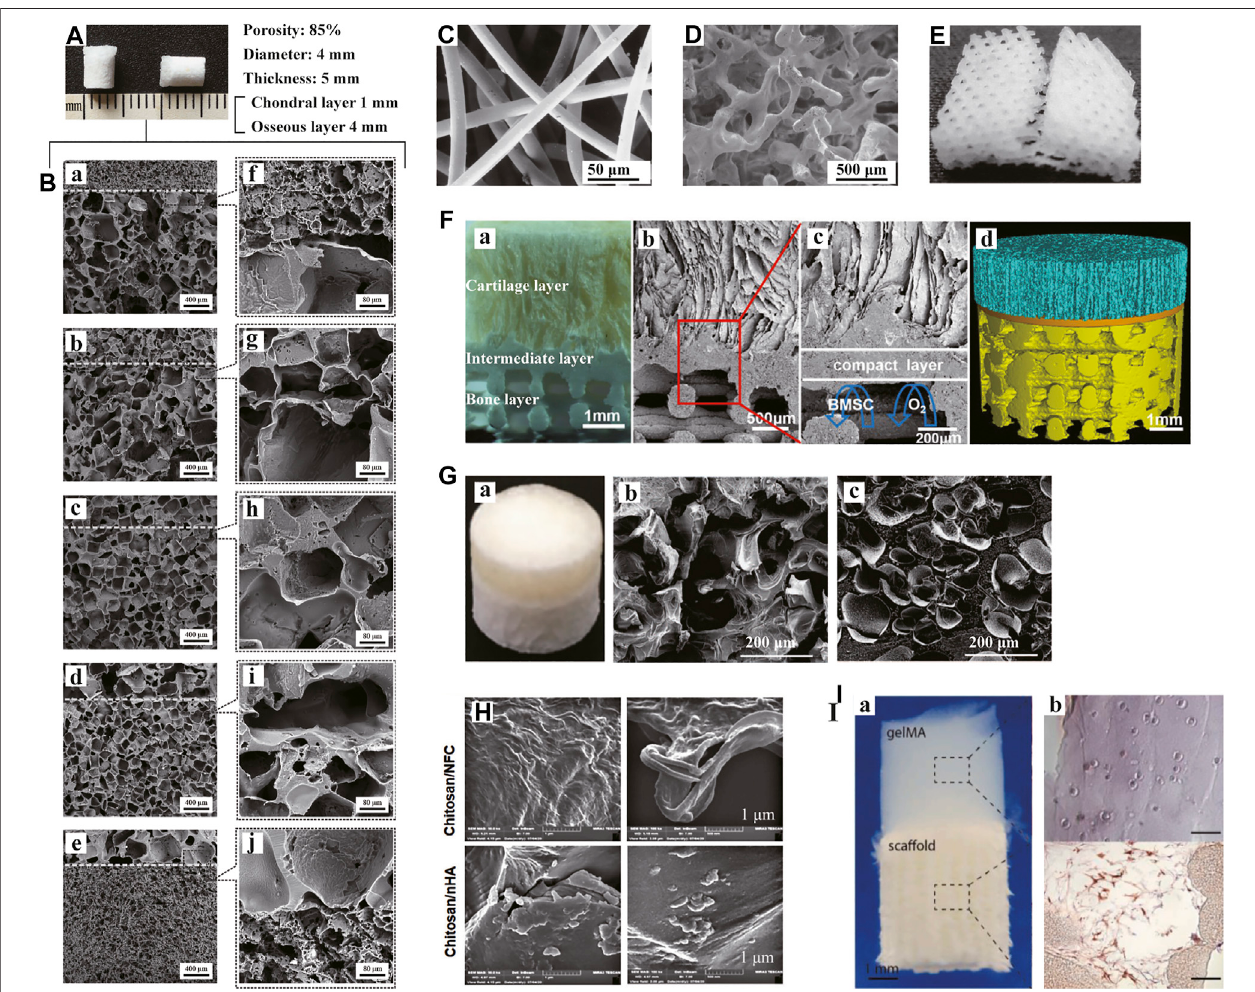
FIGURE5| Porousandhydrogelscaffolds.BilayeredPLGAporousscaffolds (A) withdifferentporesizesshowninscanningelectronmicroscopy(SEM)images (B: a-e) . The boundaries between the layers were magni fi ed (B: f-j) . Bilayered porous scaffold consisting of non-woven PGA meshes (C) and PLGA/PEG foams (D) . PCL porous scaffold with a 0/60/120 ° lay-down pattern (E) . Muti-layered scaffolds with porous 3D printing PLGA/TCP bone layer (F) were shown in digital pictures (F: a) , SEM images (F: b-c) and micro-CT reconstructive images (F: d) , respectively. Bilayered CAN-PAC hydrogel (G: a) and the SEM images of upper (G: b) and lower layers (G: c) . SEM images of the upper and lower layers of chitosan hydrogel scaffold (H) . Tri-phasic scaffolds made of gelMA hydrogel and PCL/HA (I: a) . CD31 immunohistochemicalanalysisshowedthepresenceofHUVECsinthePCL-PCL/HAphase (I:b) . (A,B) Adapted withpermission